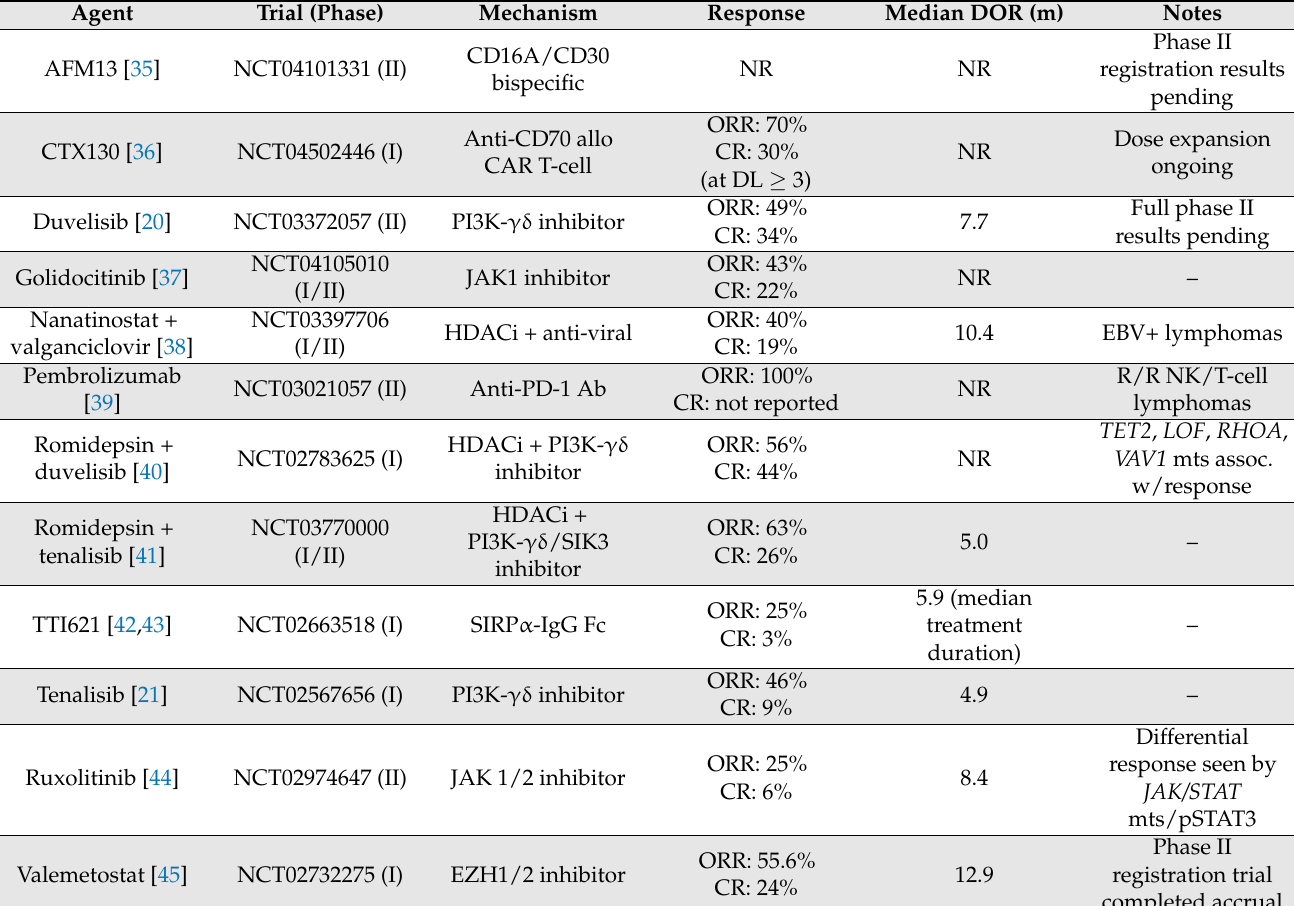
Table 3. Selected agents/regimens under investigation in relapsed/refractory T-cell